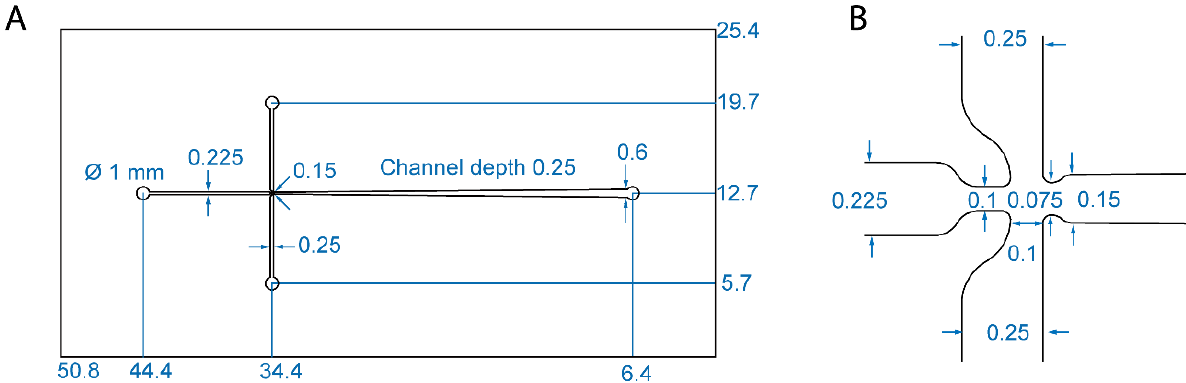
Figure A1. Detailed schematic of the layout of Mixer 3, including dimensions (in mm). ( A ) Overview of the quartz chip. Channel depth is 0.25 mm. ( B ) Expanded diagram of the mixing region at the intersection of the cross-channels.